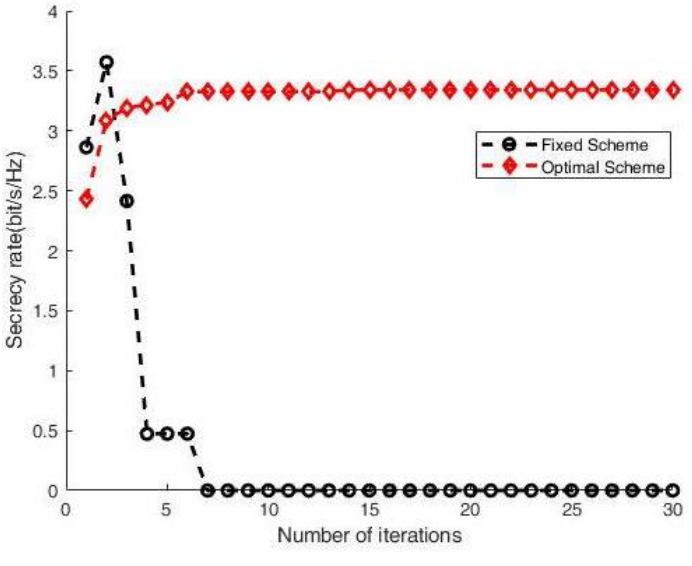
Figure 4. Secrecy rate comparison between fixed relay case and moving relay scheme.